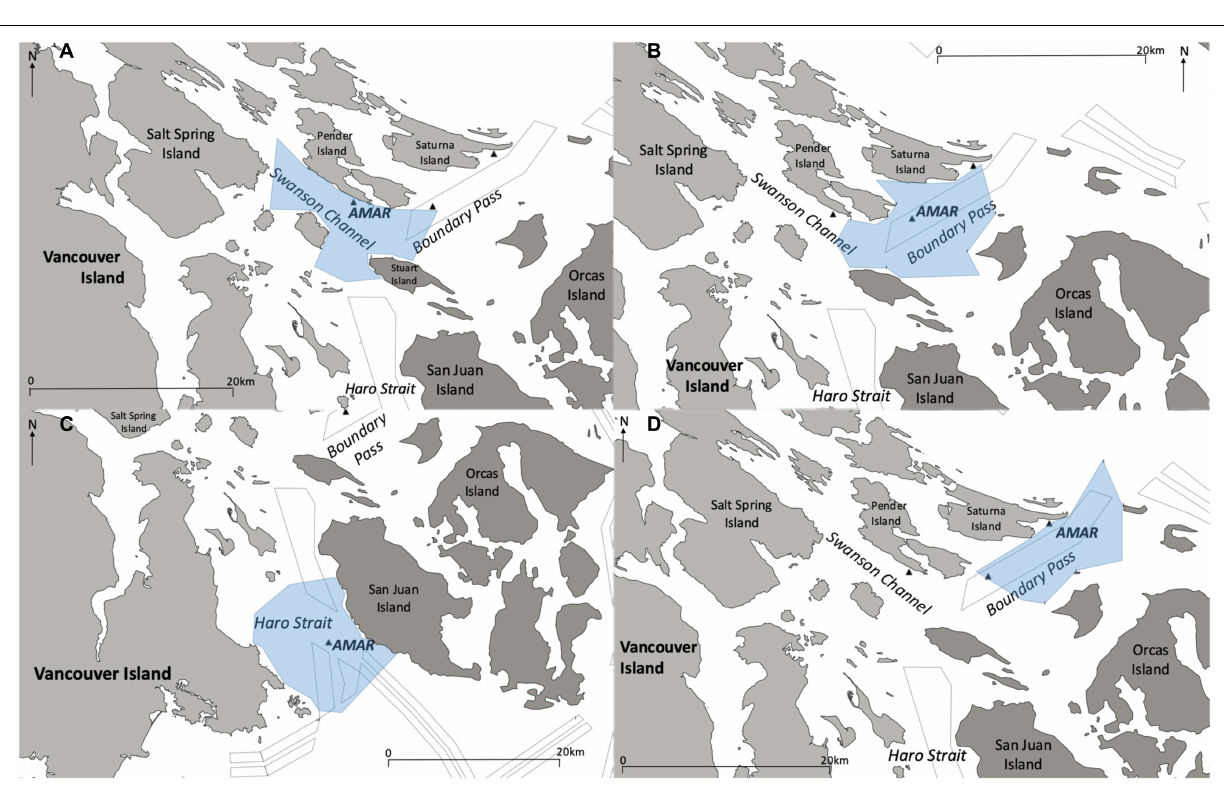
Frontiers in Marine Science |